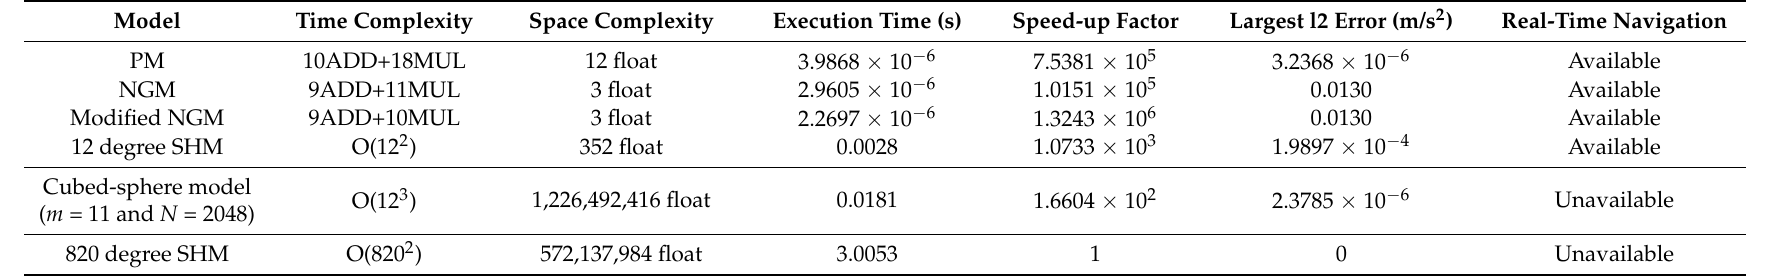
Table 5. Comparison of models’